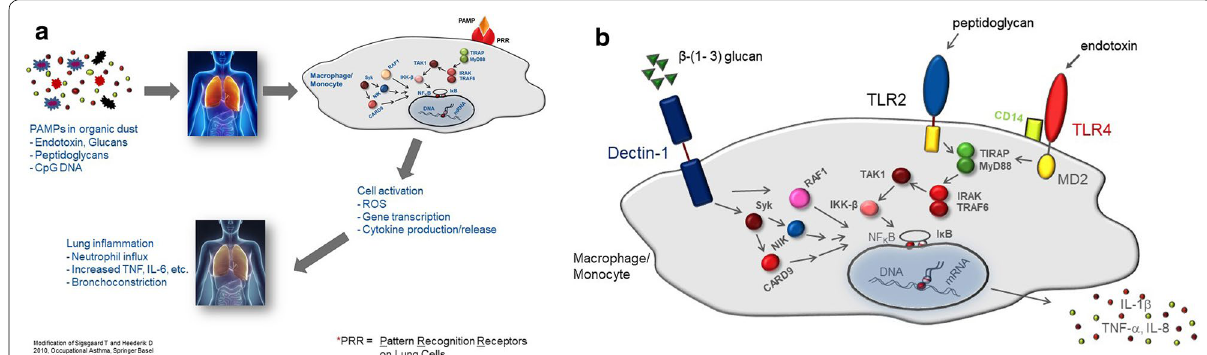
Fig. 1 Mechanism PAMP‑induced innate immunity responses to microbial agents. Examples for PAMPs (activators of the innate immune system) Endotoxin (LPS) signaling through TLR4‑pathway expression TLR4 LPS induced inflammatory response (e.g. RSV increased TLR4) although LPS causes inflammation in everyone, people with asthma tend to be more sensitive several proteins are involved in LPS‑response. Peptidoglycan signaling by TLR2 and, PGRPs (peptidoglycan recognition proteins), and NODs (nucleotide‑binding oligomerization domain molecules) b(1 3)‑glucans (polymers of glucose produced in fungi, plants and some bacteria) Dectin‑1, expressed on macrophages and neutrophils, is the → b‑glucan receptor Dectin‑1 may function as a T cell co‑stimulatory molecule, suggesting that b‑glucan stimulation may be a link between